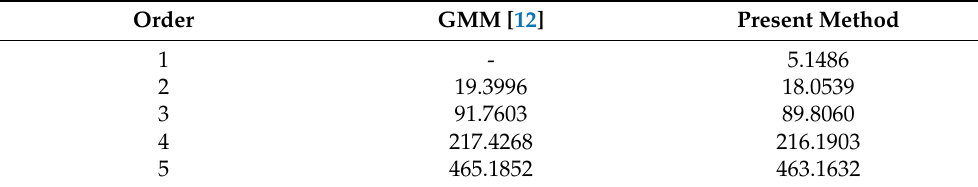
Table 1. Geometrical and Material Parameters of an SFF manipulator.